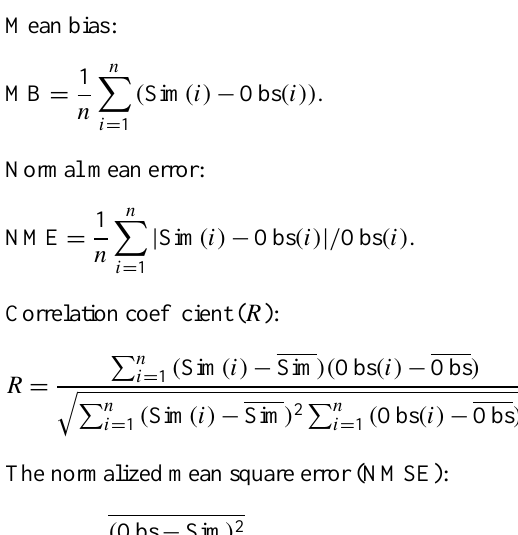
Table A1. API values and corresponding pollutant concentration (daily, unit: mg m − 3